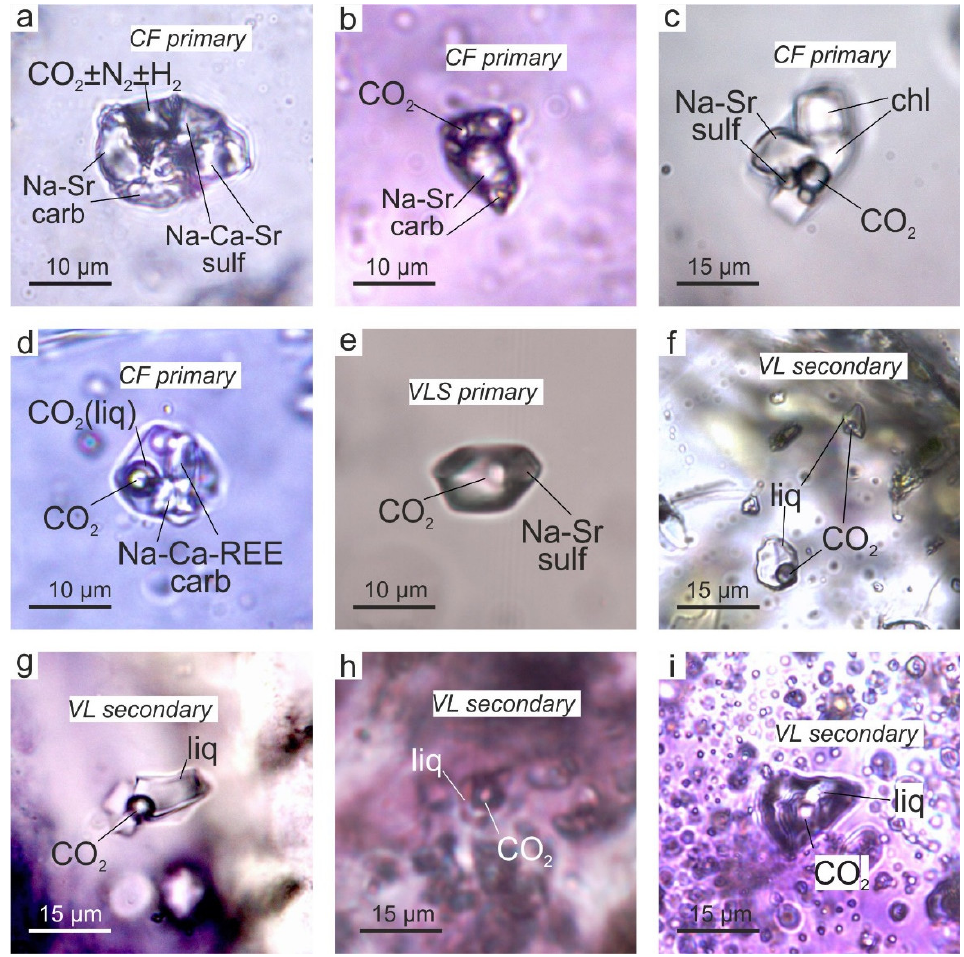
Figure 3. Primary inclusions in fluorite: ( a , b ) CF inclusions from Arshan occurrence; ( c , d ) CF inclusions from Ulan-Ude occurrence; ( e ) VLS inclusion from Yuzhnoe occurrence. Secondary inclusions in fluorite: ( f , g ) VL inclusions from Arshan occurrence; ( h ) VL inclusions from Yuzhnoe occurrence;